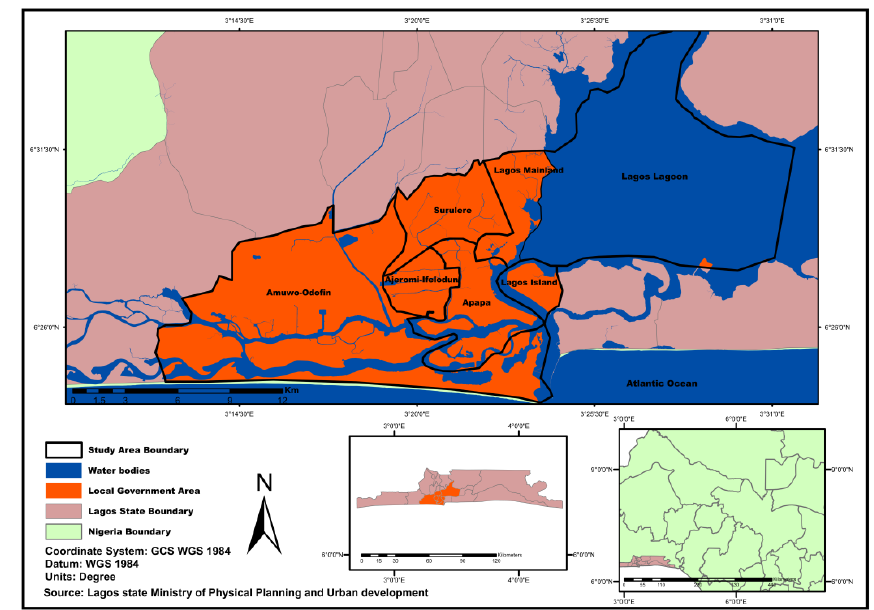
Figure 1. Study area in Lagos State,